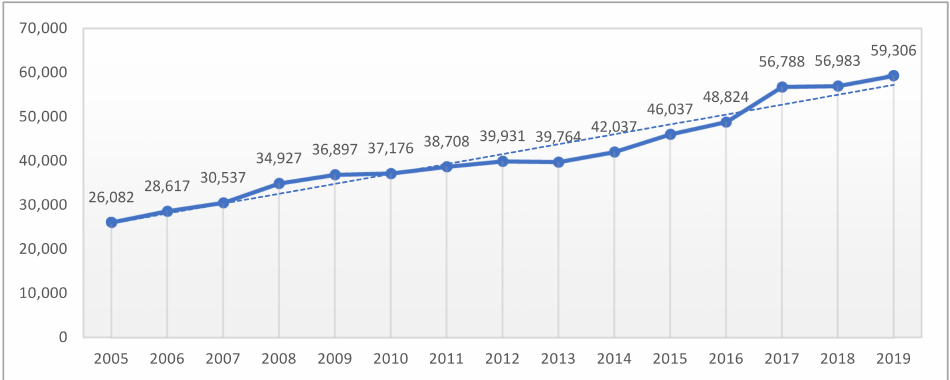
Figure 1. Number of hip arthroplasty procedures conducted in 2005–2019 in Poland according to realization reports from the National Health